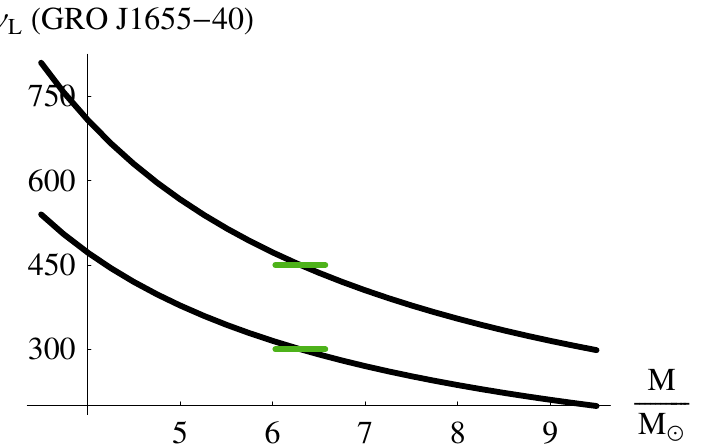
Figure 12. Fitting the particle oscillation upper and lower frequencies to the observed frequencies (in Hz) for the microquasar GRO J1655-40 at the 3/2 resonance radius. In the black plots the microquasar is treated as a quantum deformed Kerr BH given by (76) with b 0 = 1.0787i (i 2 = − 1). The upper black curve represents ν U = ν θ and the lower black curve represents ν L = ν r with ν U / ν L = 3/2, and the green curve represent the mass error band as given in (79).